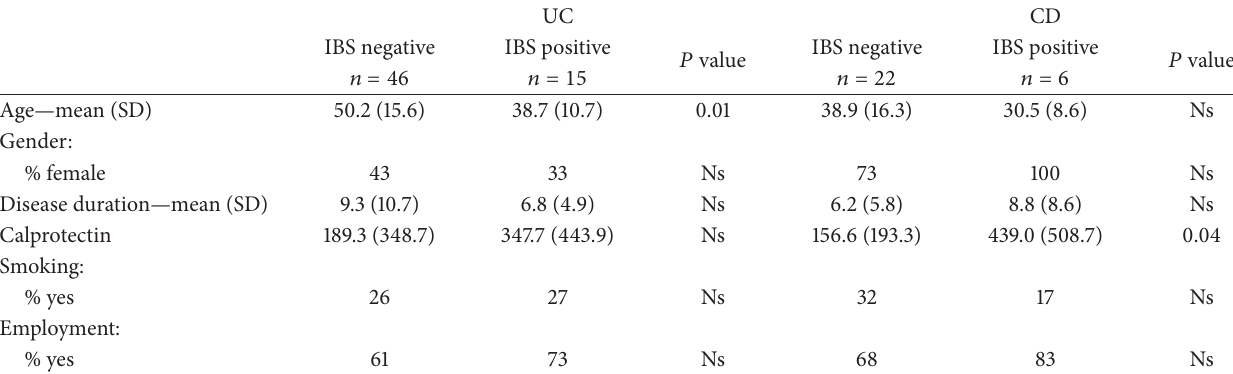
Table 1: Sociodemographic and clinical data among IBD patients with or without IBS.